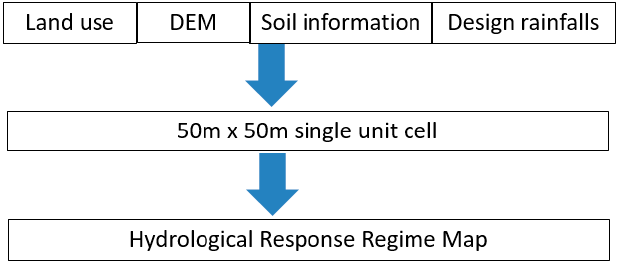
Figure 1. Methodology for determining the hydrological response regime. Digital elevation model (DEM).